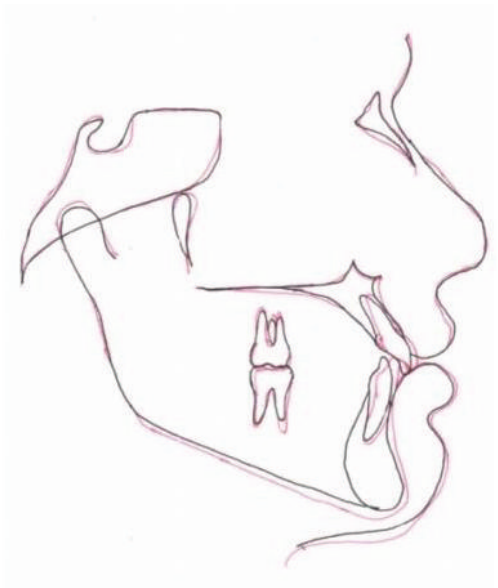
Figure 5: Superimpositions showing maxillary incisor proclina- tion, molar distalization, and mild opening of the mandibular plane